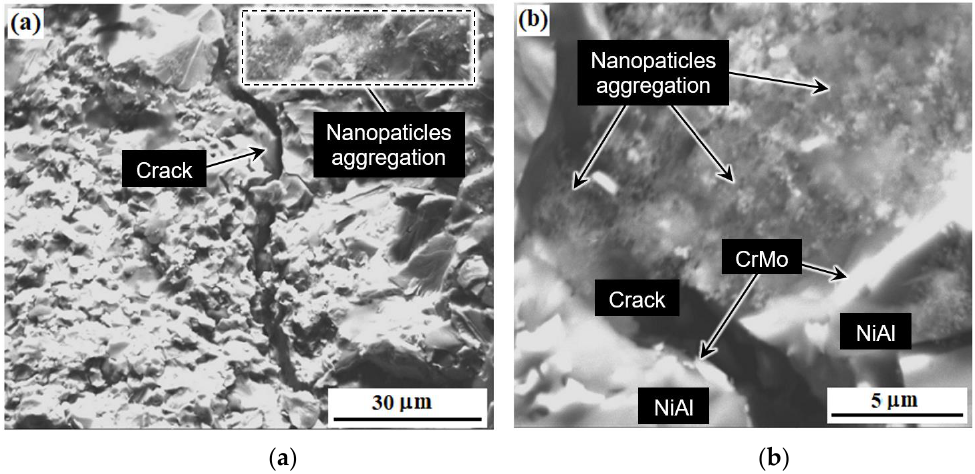
Figure 12. The microstructure of the material M-0.01 wt.% of MgAl 2 O 4 after bending tests: microstructure of the formed crack area ( a ), clusters of aluminum-magnesium spinel nanoparticles ( b ).